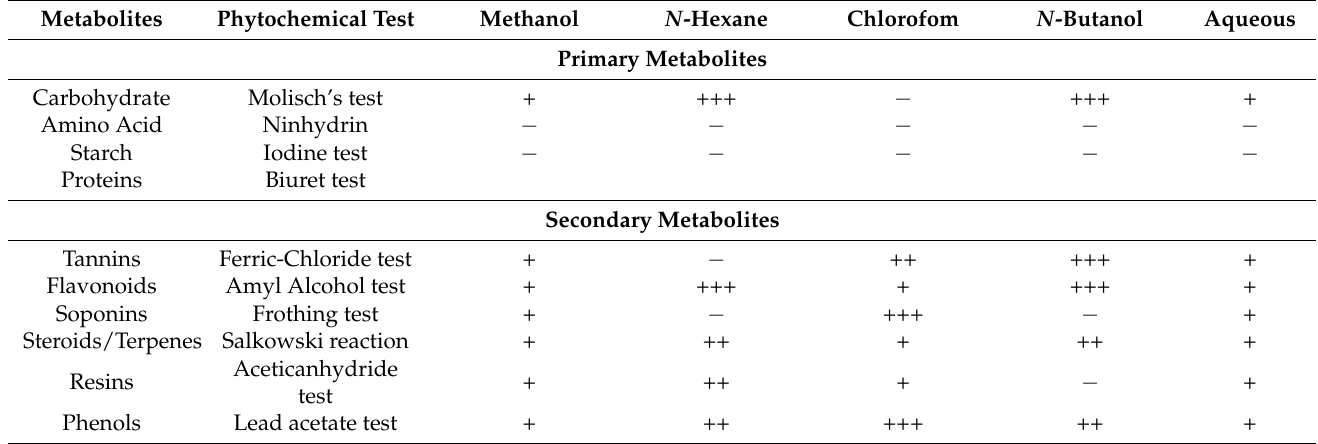
Table 1. Preliminary phytochemical screening of Neurada procumbens tested